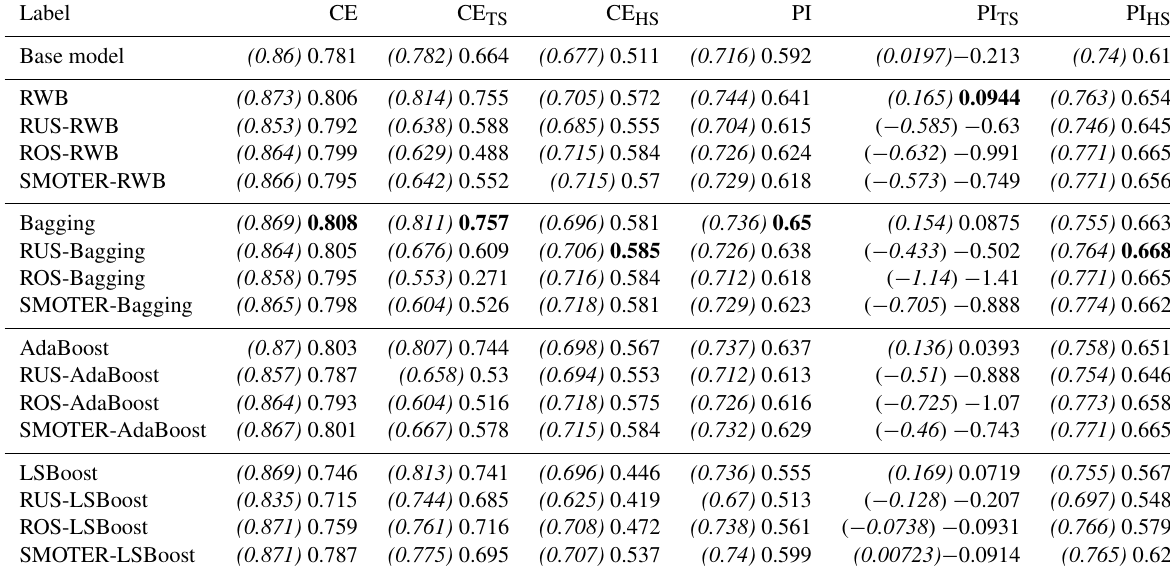
Table 6. Mean CE and PI scores for all, typical, and high stage for the Don River ensembles; the highest scores are shown in bold, and the calibration scores are italicised and enclosed by